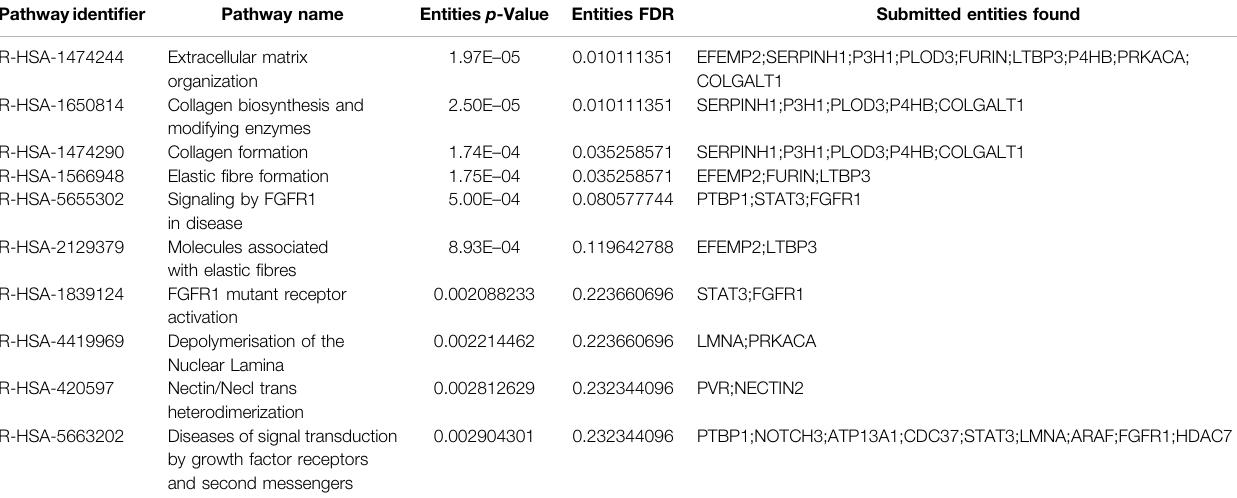
TABLE 4 | Reactome pathways analysis for predicted co-expression genes of SYDE1 in